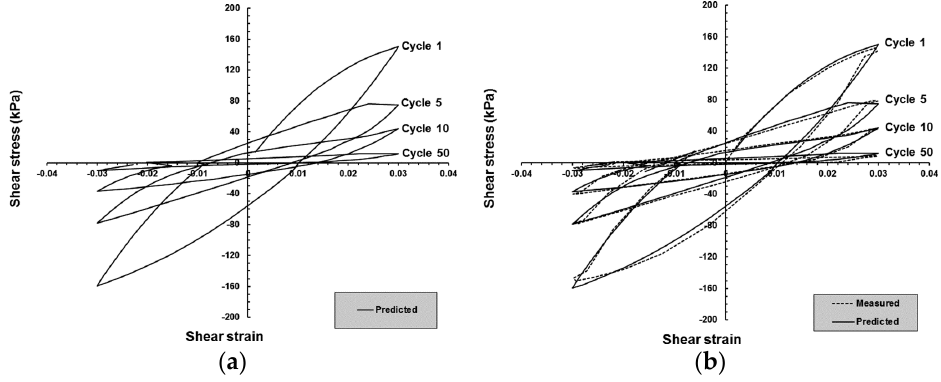
Figure 14. Numerical interpolation results: ( a ) predicted; ( b ) comparison between measured and predicted results. Table 5. Gradient for back-prediction.